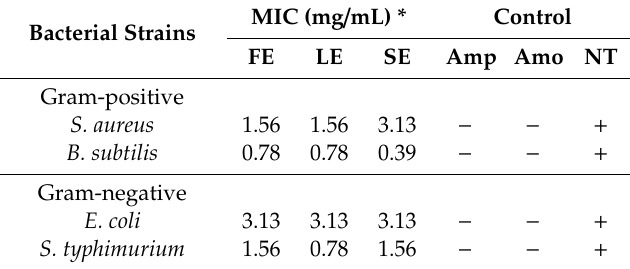
Table 6. Minimum inhibitory concentration (MIC) of edible and non-edible parts of broccoli. Bacterial